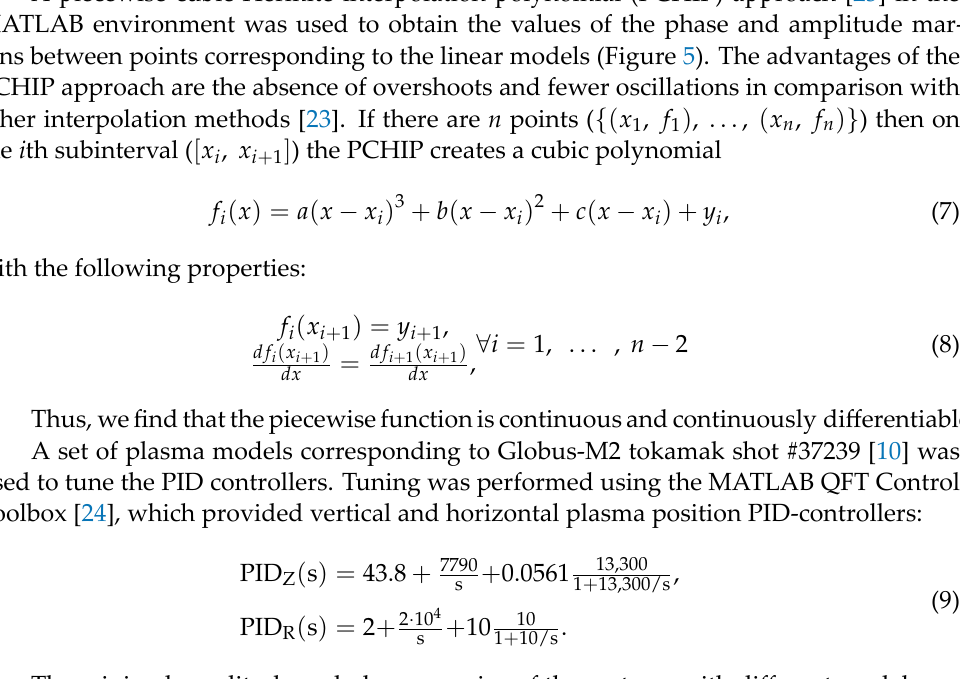
Figure 5. Changes in stability margins during a plasma discharge. Circles denote the minimums of the phase and amplitude margins in this system. Here and below, solid lines between circles were obtained with the PCHIP approach, (7) and (8) [23].